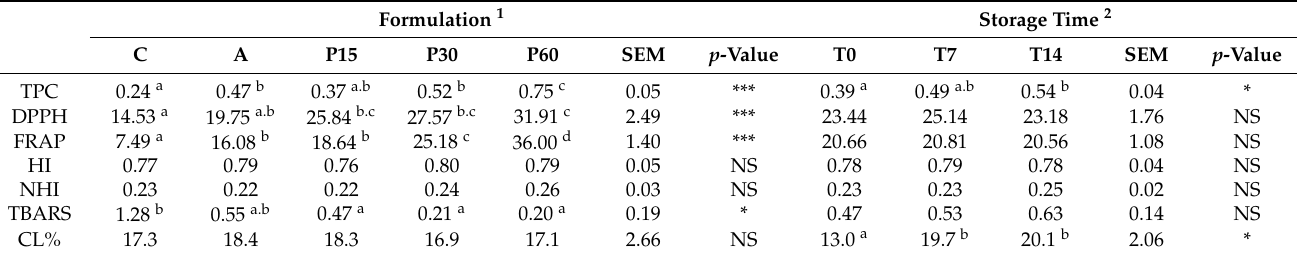
Table 3. Estimated marginal means and standard error of the mean (SEM) of total phenolic content (TPC, g GA eq. /kg), antioxidant capacities (DPPH and FRAP, mmol Trolox eq./kgdw), heme iron (HI, mg/100 g) and non-heme iron (NHI, mg/100 g), lipid oxidation (TBARS; mg MDA eq./kg), and cooking loss percentage (CL%) of the cooked pork burgers. Formulation 1 Storage Time